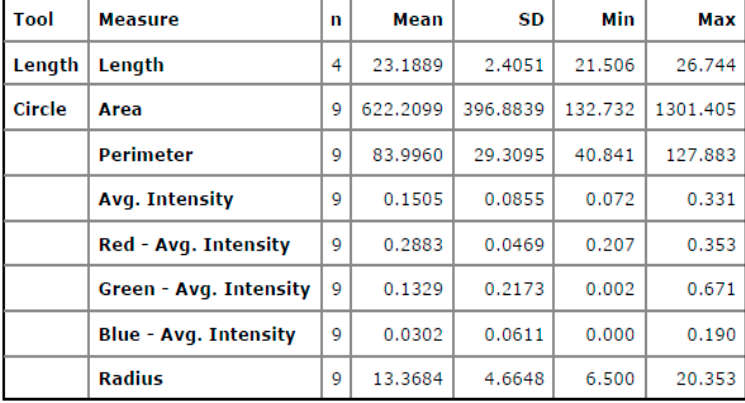
Figure 13. Screen shot of the statistical measurements of the segments at the optimized parameters.